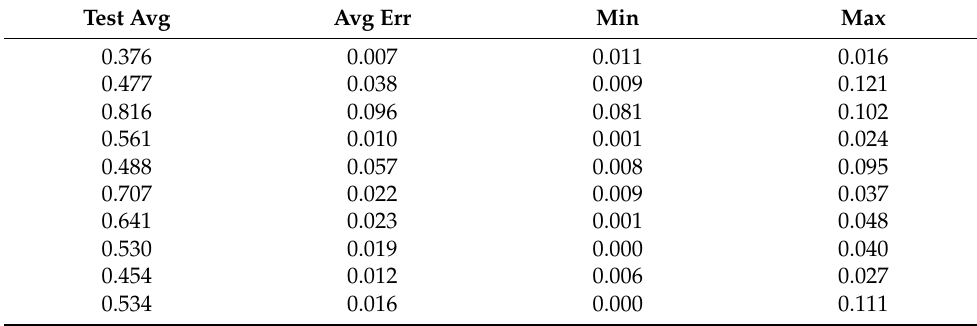
Table A222. Set 3, trials 41–50 data (actual PR value).